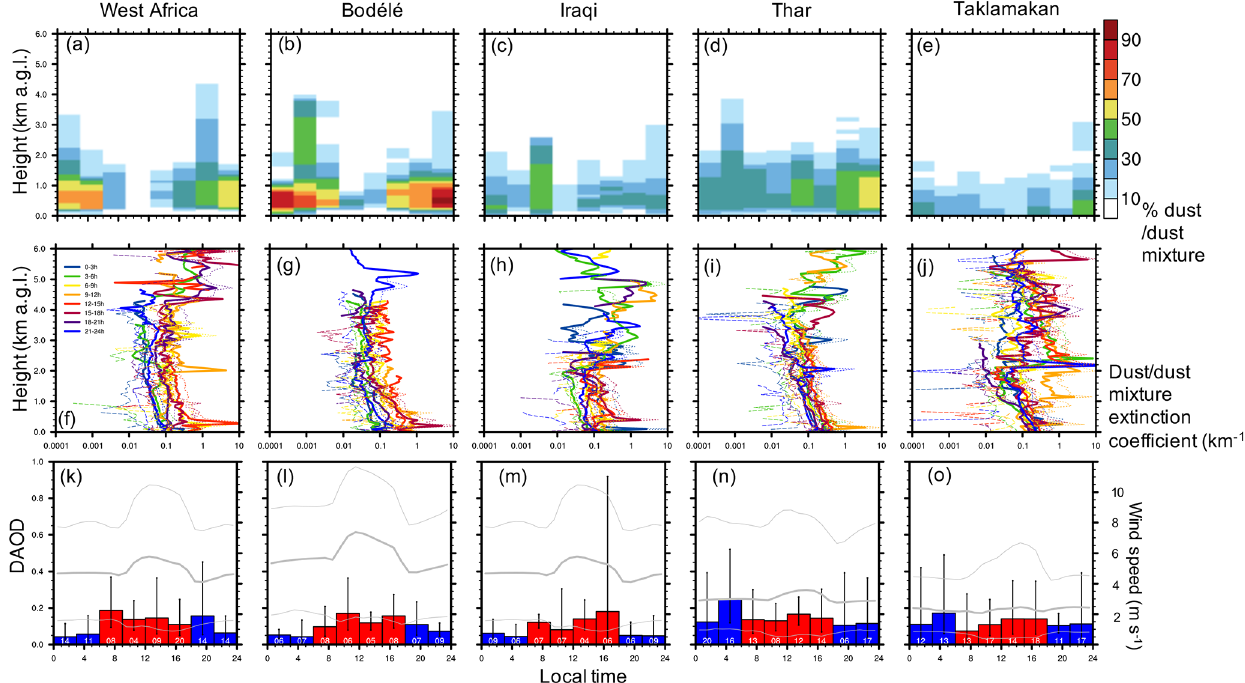
Figure 11. Diurnal cycle of dust and dust mixture characteristics observed by CATS over five key dust source regions during boreal spring (March–May, MAM). Figure elements are the same as in Fig. 10.